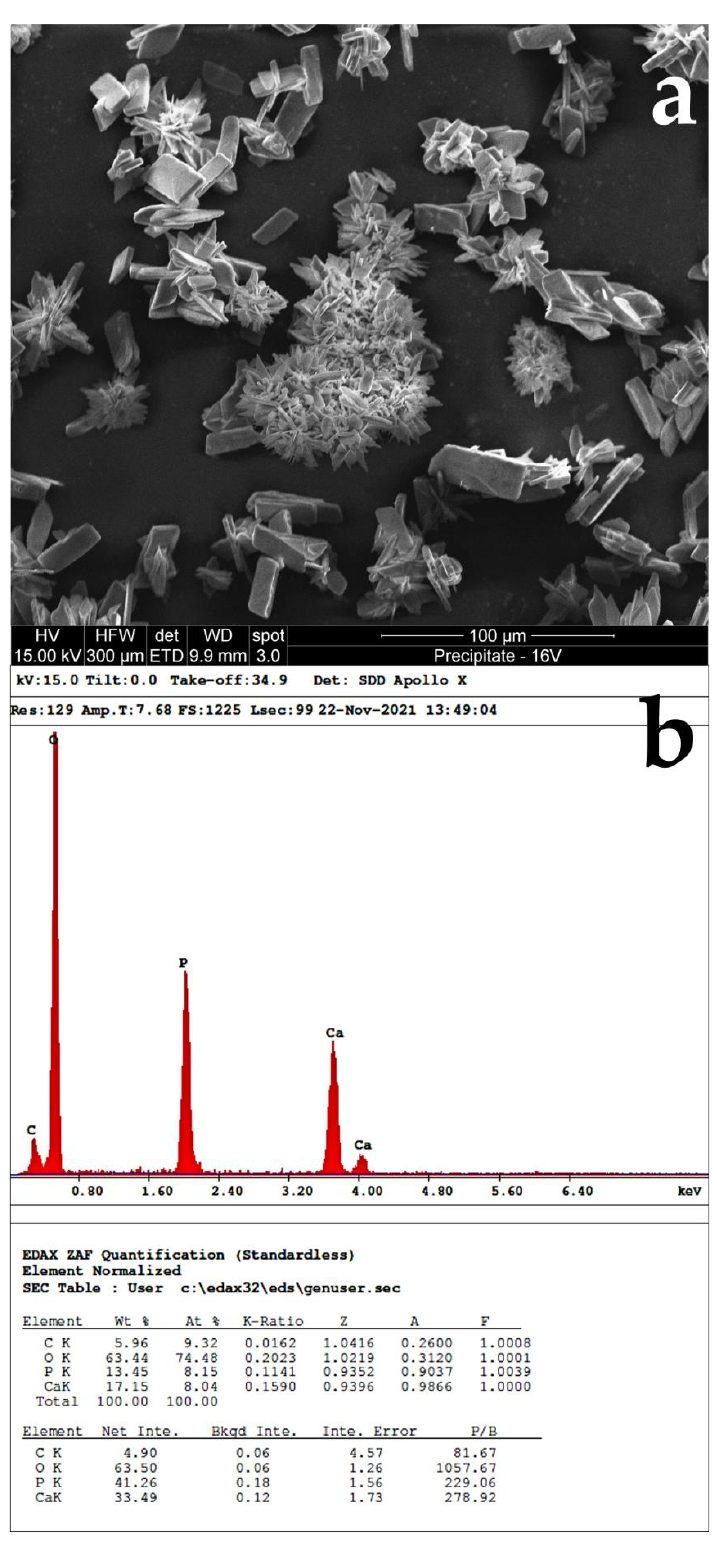
Figure 6. CaP precipitate analysis via SEM and energy dispersive X-ray spectroscopy (EDX). ( a ) Typical plate and flower like structures are observed in the SEM image. ( b ) The respective EDX scan shows a Ca/P ratio of 1.11.